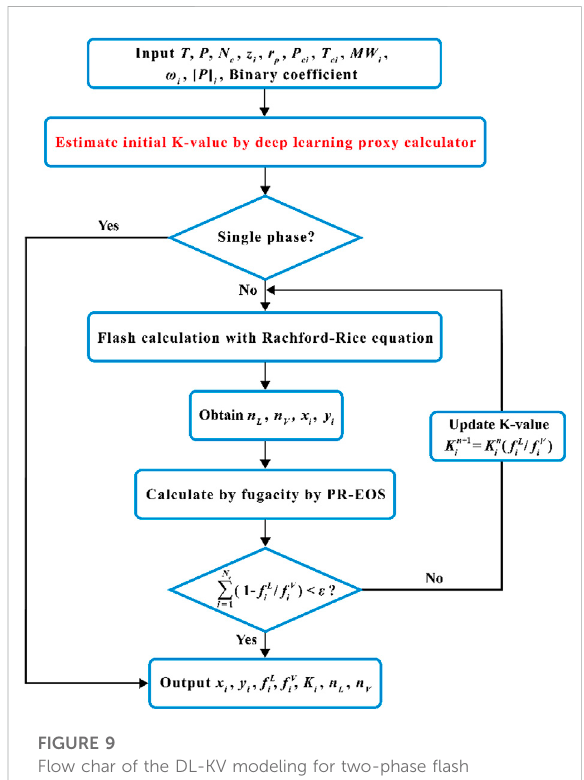
FIGURE 9 Flow char of the DL-KV modeling for two-phase fl ash